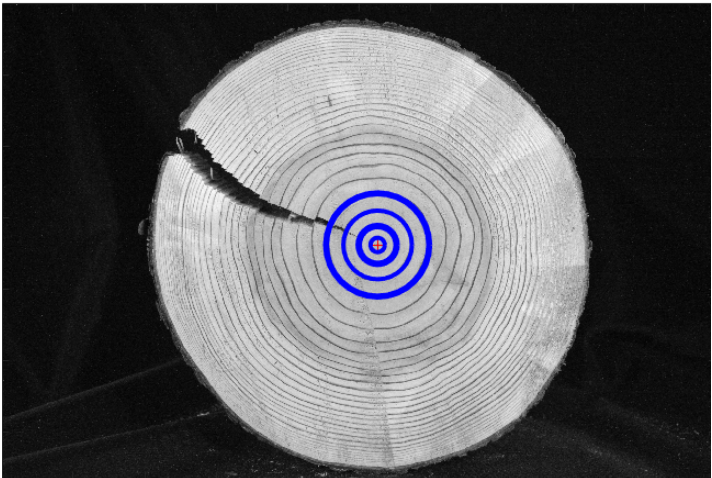
Figure 2. Finding the center of annual